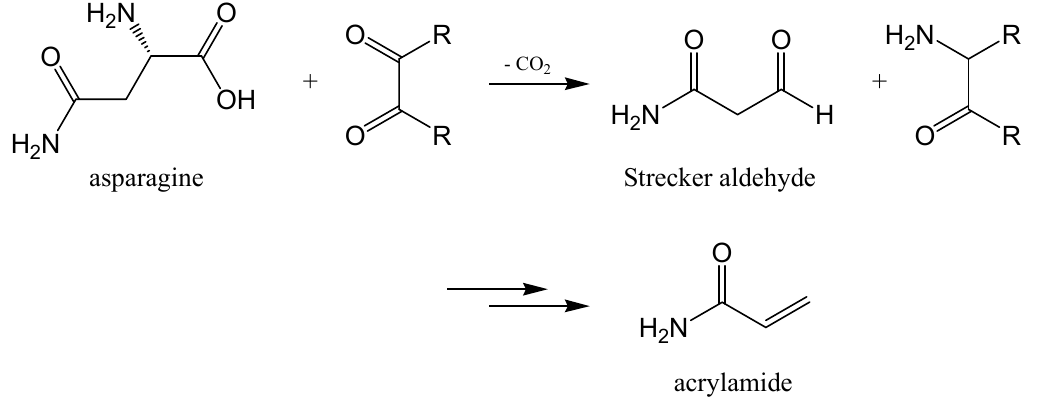
Figure 1. Strecker decomposition of